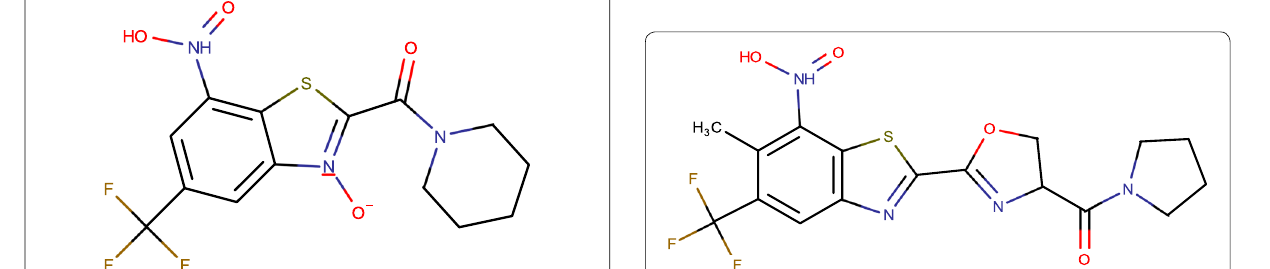
Fig. 6 Benzothiazole- N -oxide Fig. 7